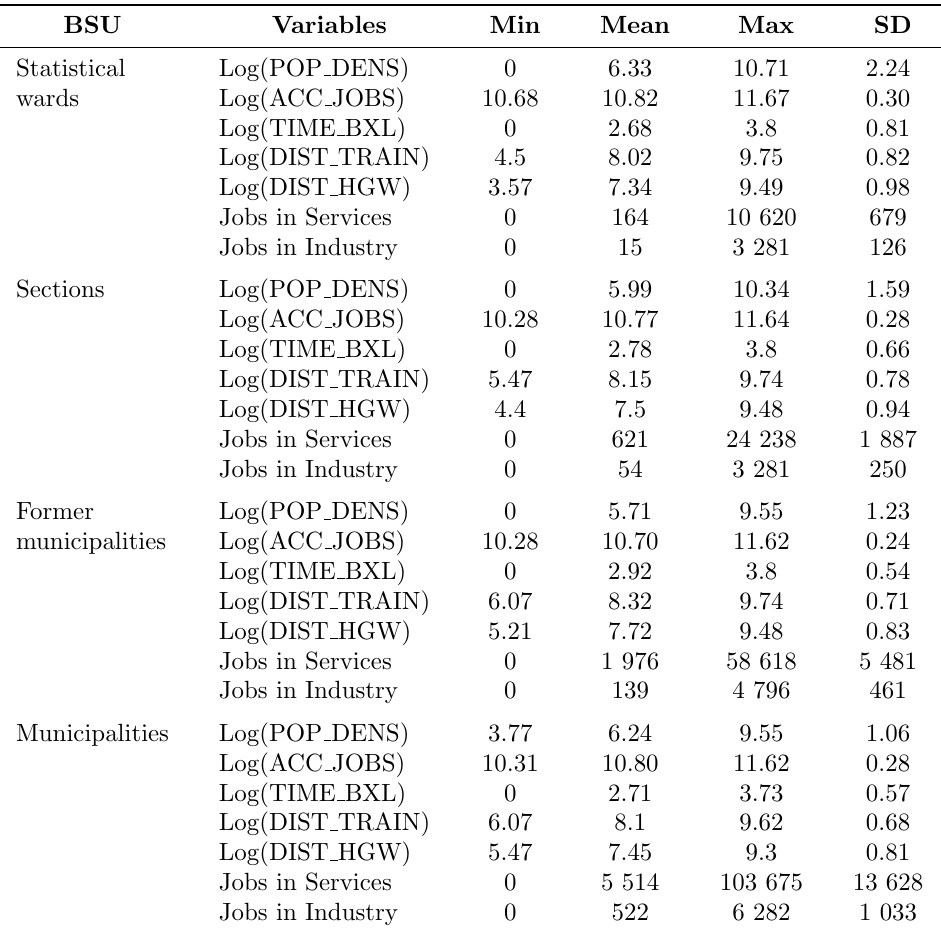
Table 2: Summary statistics of location choices determinants for the RER zone (SD = standard